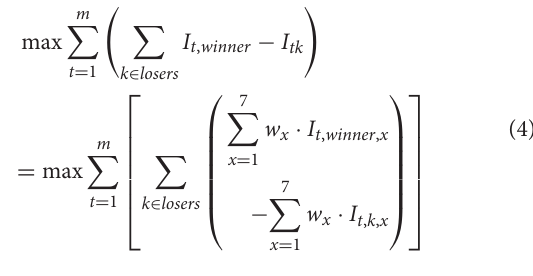
far phase of the personal space (0.76–1.22 m) or at the social